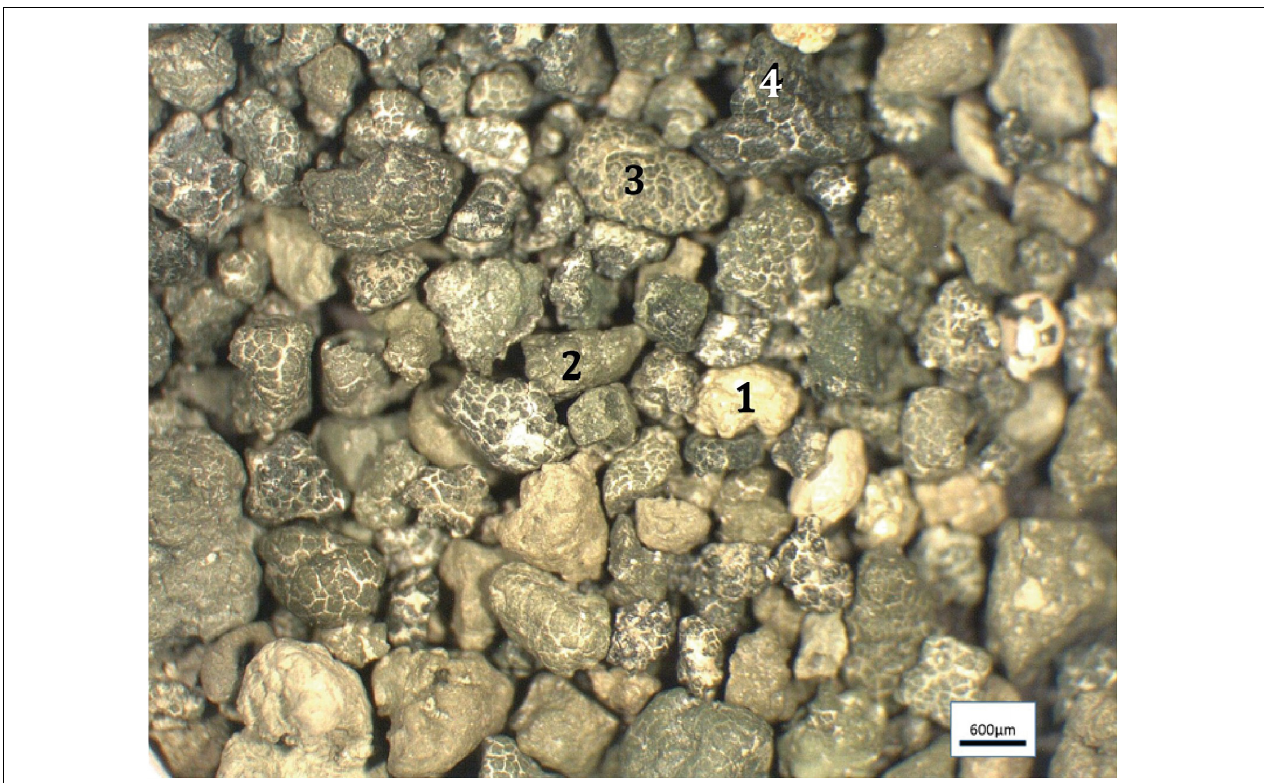
FIGURE 4 | Photograph showing the various degrees of glauconitic maturity inferred from colour and characteristic cracks. (1) Beige grains; (2) light green grains; (3) light green grains with cracks; and (4) dark green grains with